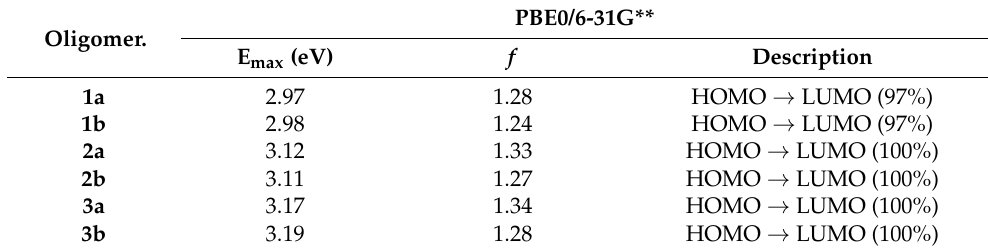
Table 5. DFT-calculated vertical excitation energies.